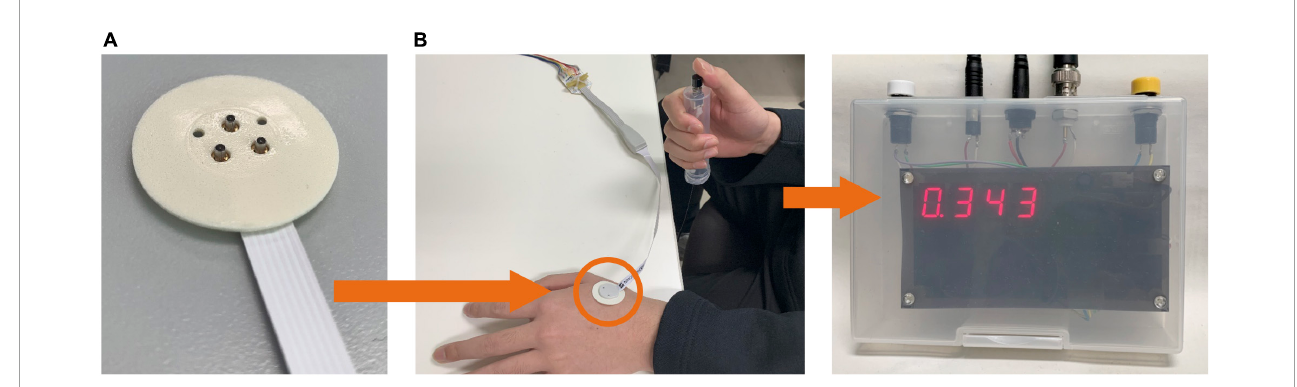
FIGURE1 Experimental setup. (A) The stimulation device delivers an electric current via a concentric bipolar needle electrode attached to the left hand. (B) The participant presses a button during the perception threshold experiment to record the reaction